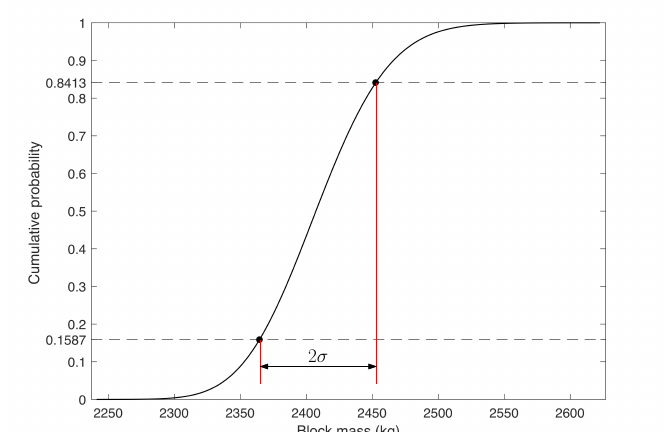
Figure 4. Cumulative probability distribution of the masses at T = 20 years ( α = 1.2, λ = 0.1 events/yr, N = 1000, V th = 0.5 m 3 ). The dots mark the masses corresponding to percentiles 15.87 and 84.13. The difference between the corresponding masses is twice the standard deviation of the equivalent normal